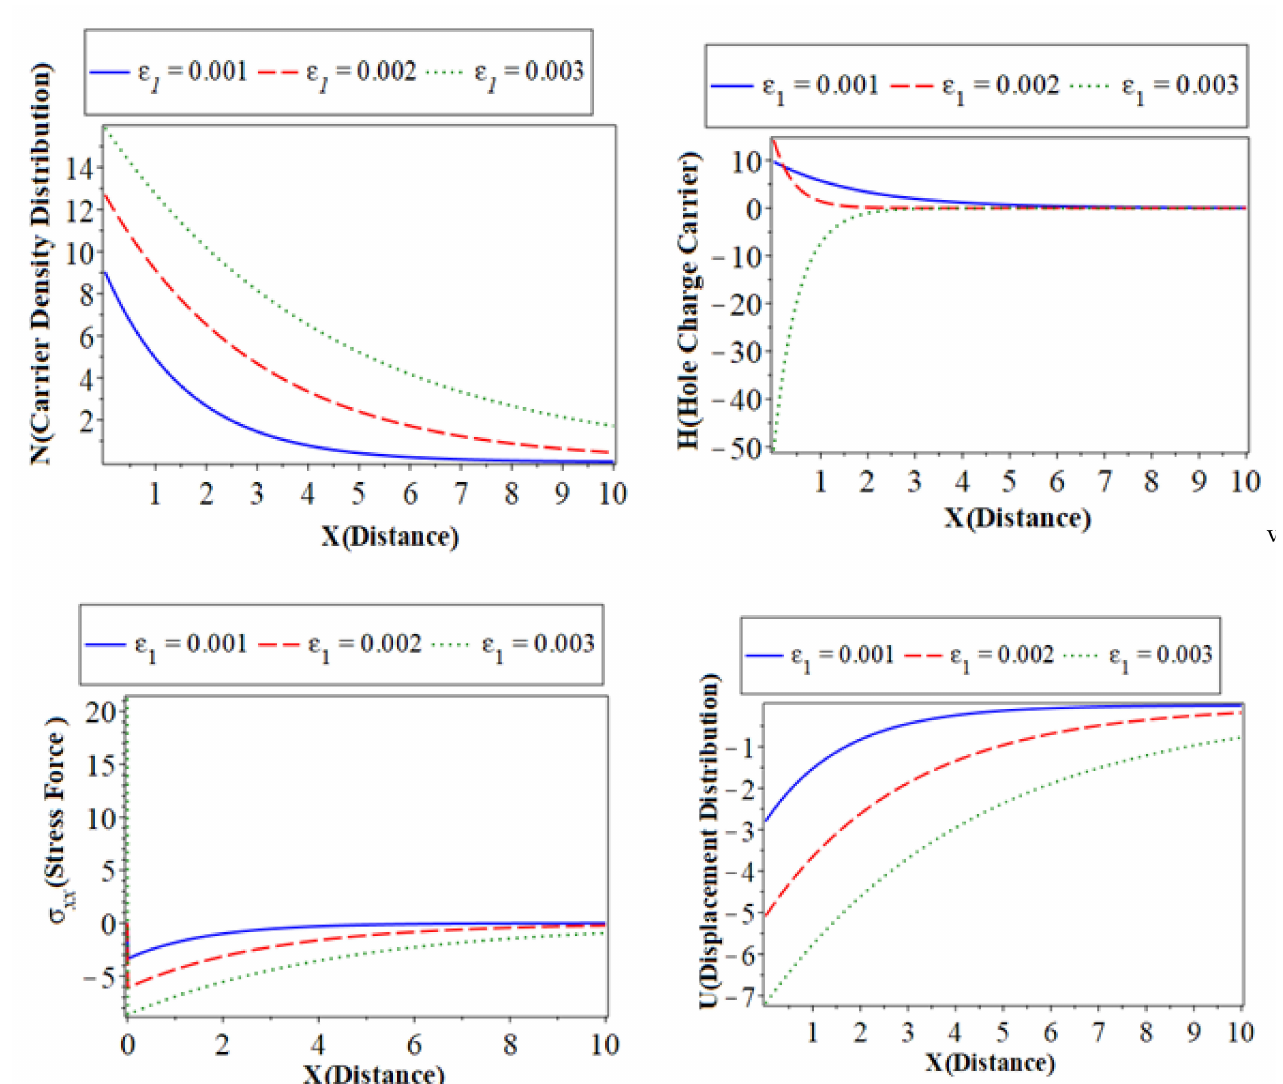
Figure 1. The variation of physical field distributions with distance at different values of the thermoe- lastic coupling parameter ( ε 1 ) when τ θ = 0.02, τ q = 1 and β =